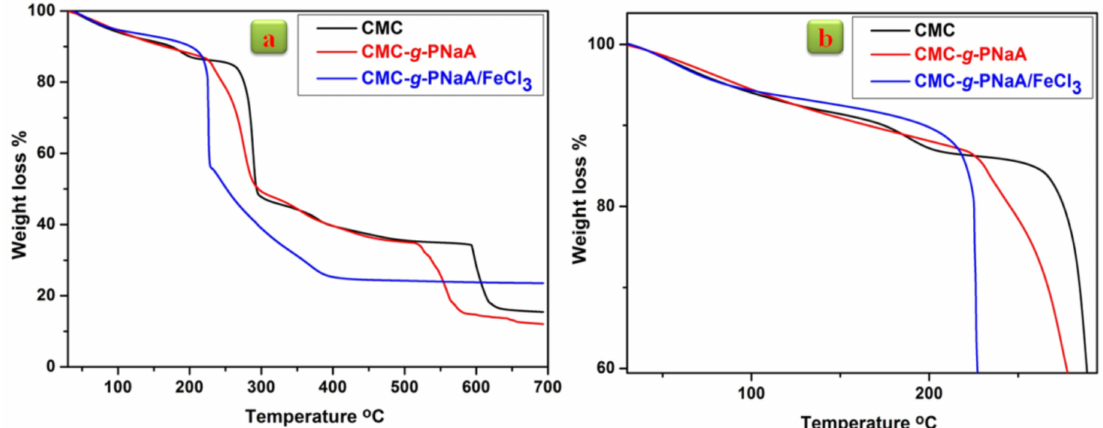
Figure 5. ( a ) Thermogravimetric analysis (TGA) curves of CMC, CMC- g -PNaA CMC- g -PNaA / FeCl 3 ; and their corresponding ( b ) extended TGA